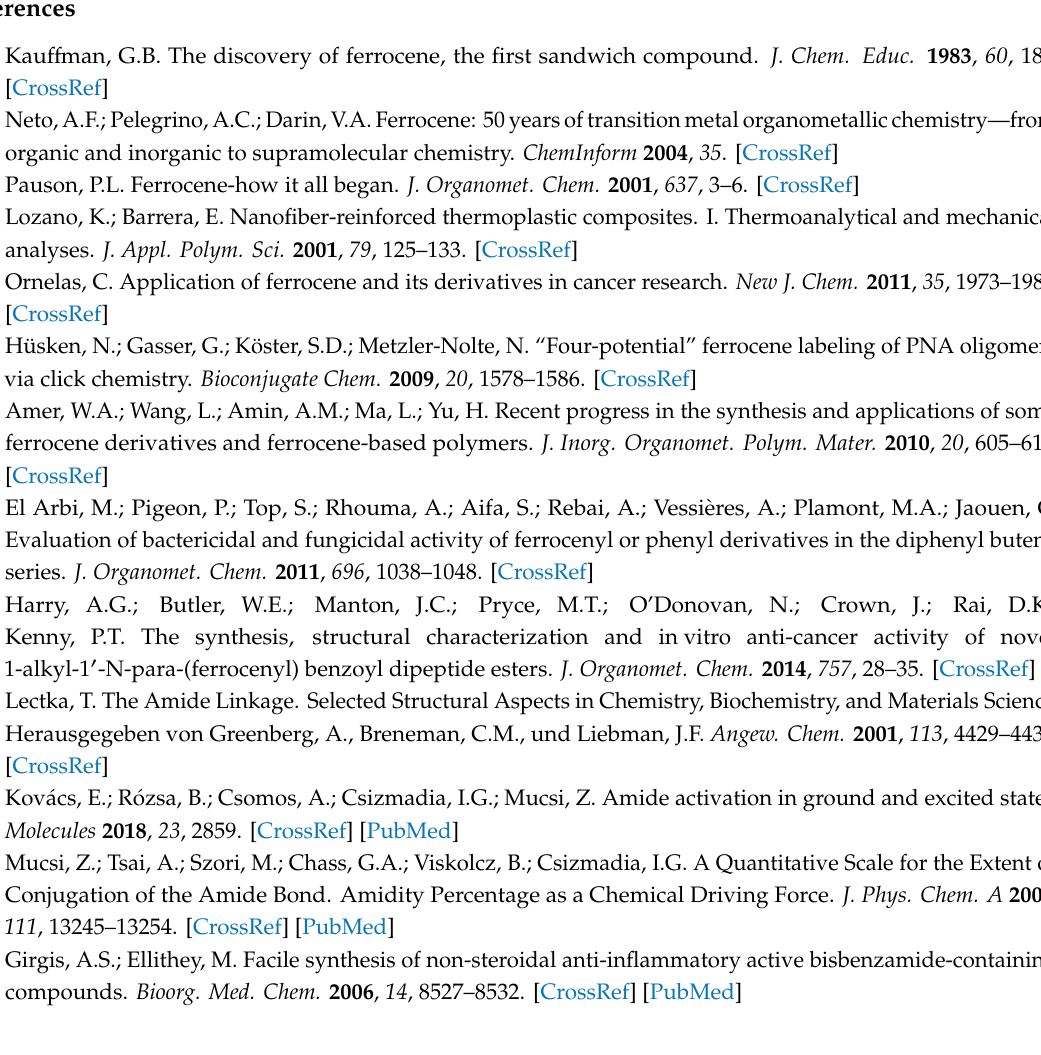
Figure S4: Alpha glucosidase enzyme inhibition activity of organic analogues, Figure S5: Alpha amylase enzyme inhibition activity of ferrocenyl amides, Figure S6: Alpha amylase enzyme inhibition activities of organic analogues, Figure S7: Acetylcholinesterase enzyme inhibition activities, Figure S8: Butyrylcholinesterase enzyme inhibition activities, Figure S9: Antibacterial activity of gram-negative bacteria, Figure S10: Antibacterial activity of gram-positive bacteria, Table S1: FTIR (cm − 1 ) spectral data of ferrocenyl amides (FB1-FB13), Table S2: FTIR (cm − 1 ) spectral data of organic analogues (BZ1-BZ13), Table S3: 1 H NMR spectral data of ferrocenyl amide and organic analogues, Table S4: 13 C NMR spectral data of ferrocenyl amides and organic analogues. Supplementary data of the crystal structure and refinement, like full bond lengths, bond angles, dihedral angles, and anisotropic displacement parameters, have been deposited, BZ2 (CCDC deposition #1824487) and BZ6 (CCDC deposition #1824488). These data can be obtained, free of charge, using the link www.ccdc.cam.ac.uk or from the CCDC, 12 Union Road Cambridge CB2 1EZ, UK; Fax: + 44-1223-336033; e-mail: